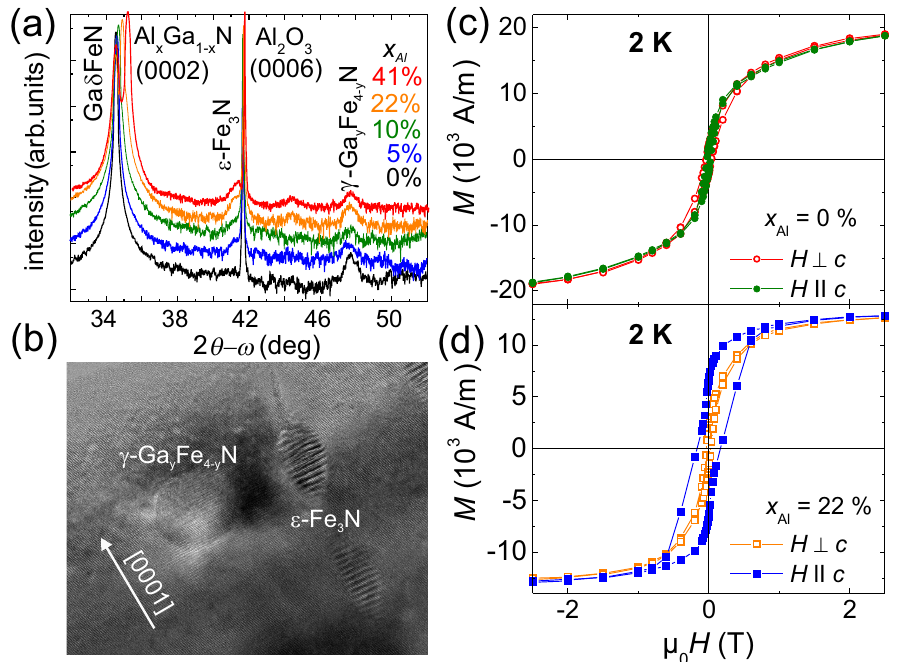
Figure 9. Shape-induced magnetic anisotropy in Ga δ FeN/Al x Ga 1 − x N heterostructures containing ε -Fe 3 N and γ ’-Ga y Fe 4 − y N as observed by ( a ) HRXRD and ( b ) HRTEM. Out-of-plane magnetic anisotropy of the layers grown on Al x Ga 1 − x N buffers with ( c ) x = 0 and ( d ) x = 0.22. Adapted from Reference